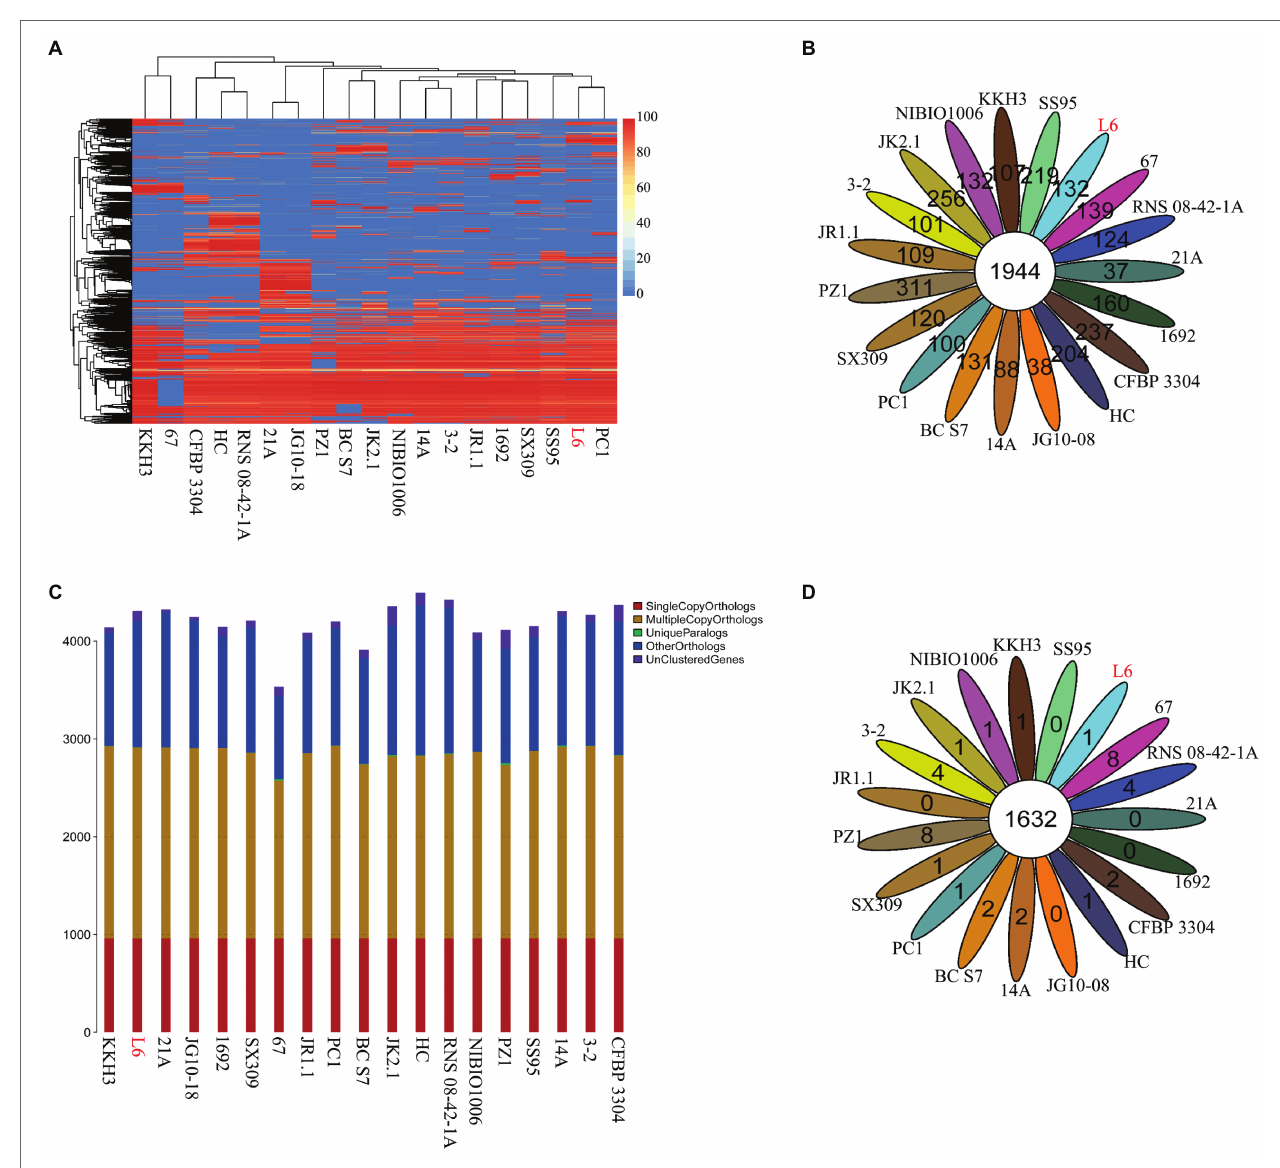
FIGURE 4 | Core genes and dispensable genes and orthologs in the P. aroidearum L6 genome and reference strain genomes. (A) Dispensable gene heat map (left, dispensable gene cluster; top, strain cluster; red gradient bar represents the scale of similarity percentage); (B) Venn diagram of pan genes (each ellipse represents one strain, and the number in the ellipse is the cluster number. One cluster has genes of >50% identity and <0.3 length diversity); (C) Ortholog number (Single Copy Orthologs, the number of single-copy homologous genes in the species common gene families; Multiple Copy Orthologs, the number of multiple-copy homologous genes in the species common gene families; Unique Paralogs, genes in specific gene families; Other Orthologs, other genes; and Unclustered Genes, genes that have not been clustered into any families); (D) Venn diagram of orthologs in gene family (each ellipse represents one strain, and the number in the ellipse is the family